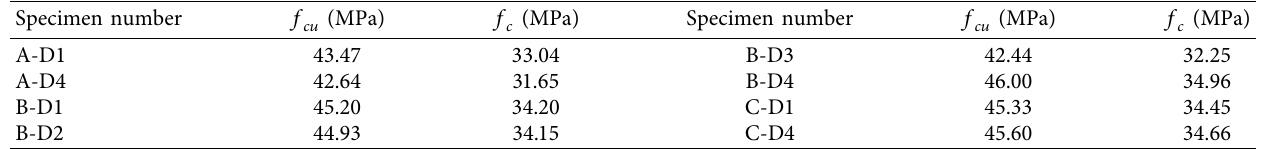
Table 3: Mechanical properties of